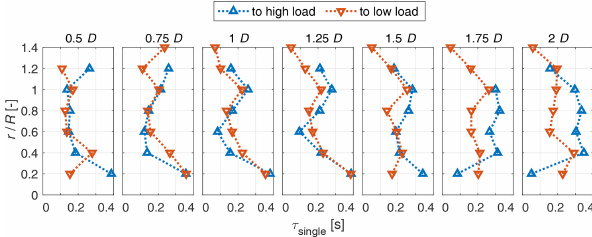
Figure C1. Spanwise evolvement of the axial wake velocity from 0.5 to 2 D parameterised by the fitted time constant of the one-time- constant model for both pitch